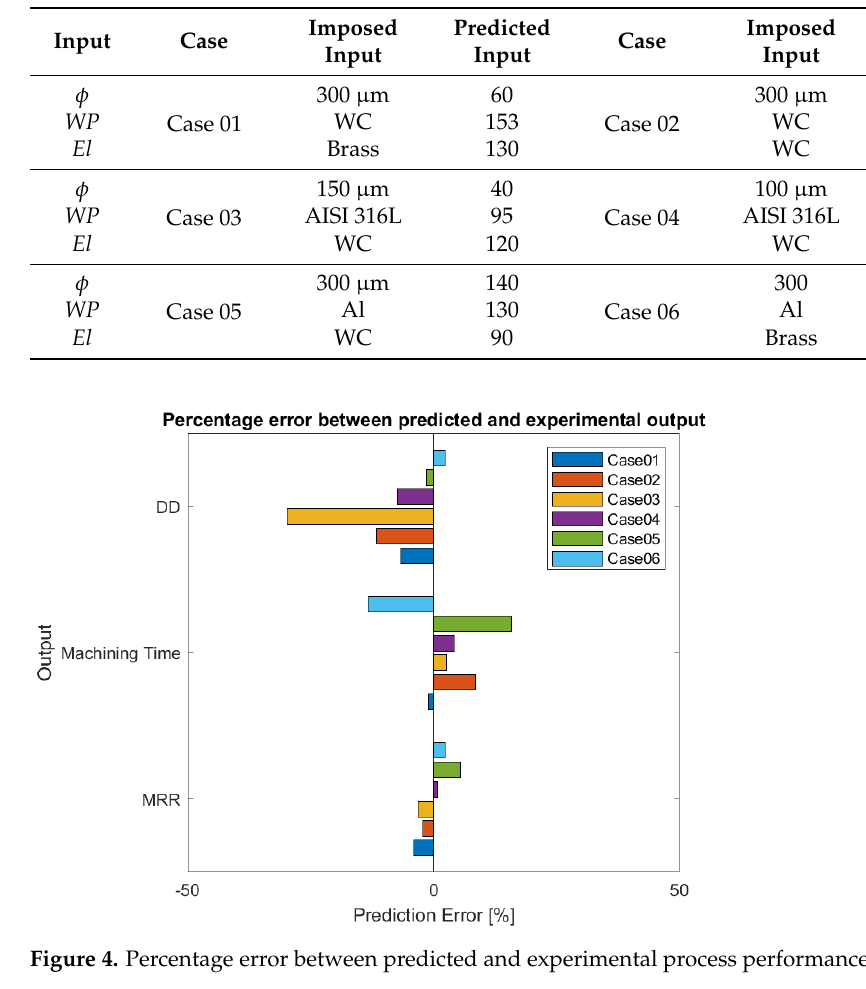
Table 1. Forced inputs and optimized process parameters.